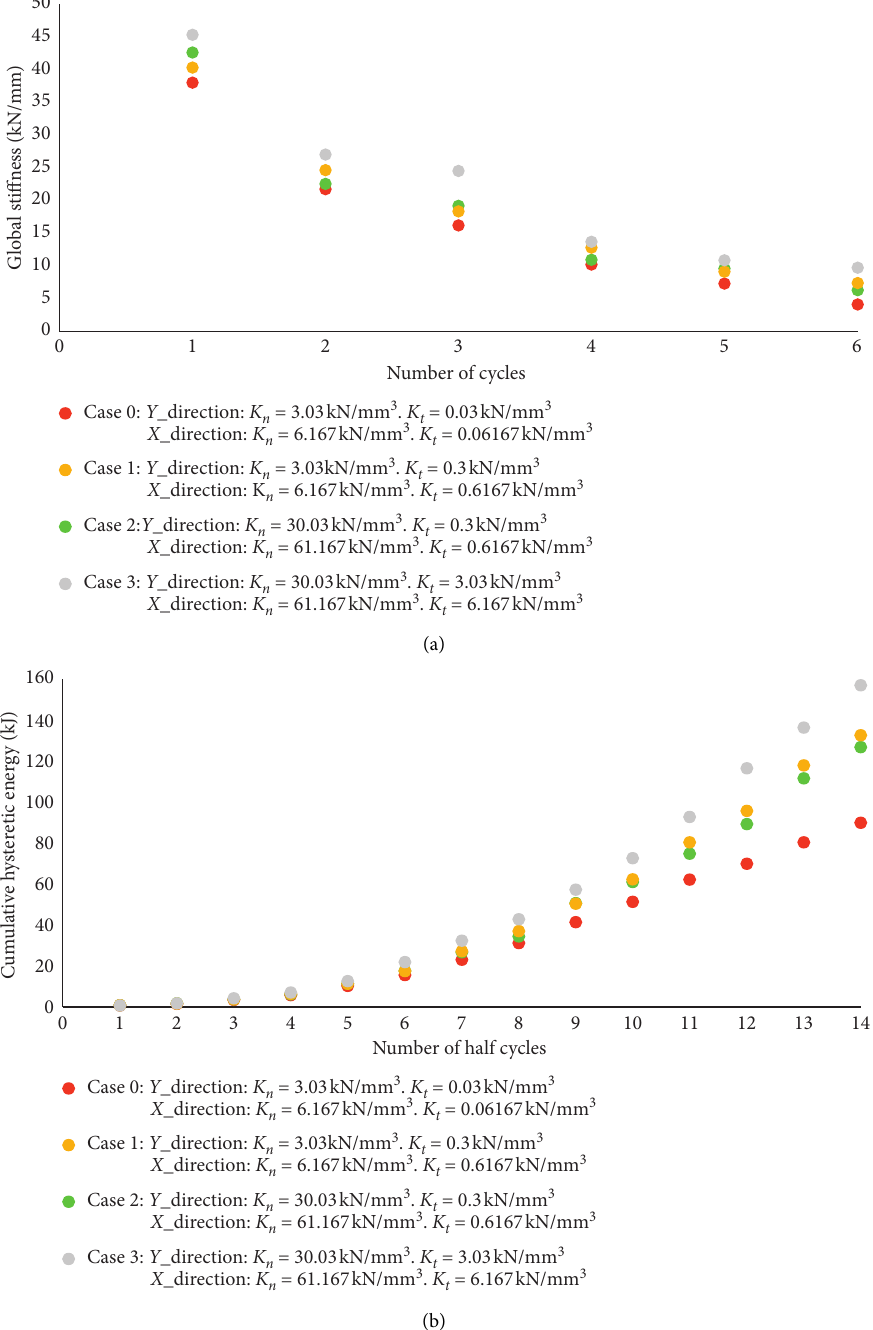
Figure 10: Comparison between numerical model results using different values in the stiffness of the interface for the TRM masonry-infilled frame in terms of the (a) global lateral stiffness per cycle and (b) cumulative global hysteretic energy per half